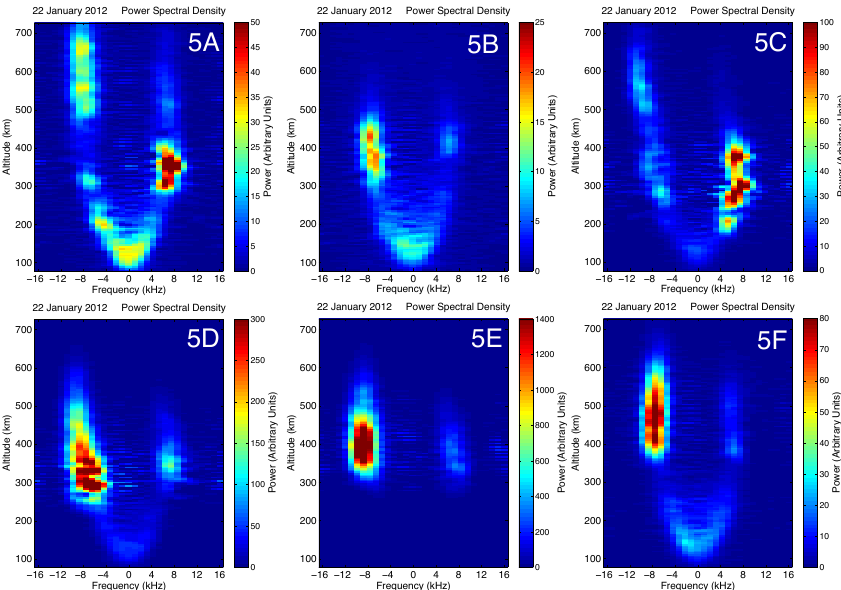
Figure 17. Event 5: NEIAL spectra from the times labeled 5A–5F in Fig. 16. The NEIAL spectra are all asymmetric, with the downshifted shoulder more enhanced than the upshifted shoulder. Note that the intensity scale is not the same for each spectra, for example, NEIAL 5E is orders of magnitude more intense than the others.